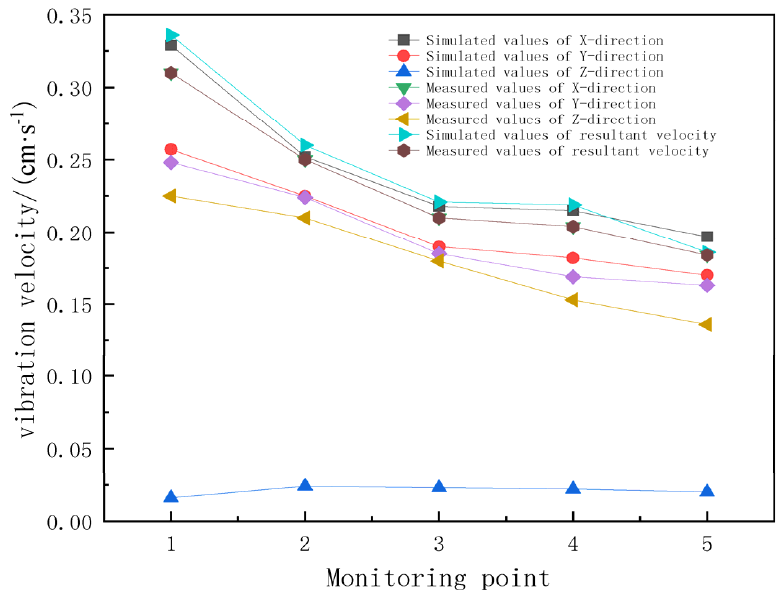
Figure 13. Comparison of numerical results with measured values for an elevation of 20 m. As can be seen from Table 6 and Figure 13, the numerical simulation results are generally greater than the field test vibration velocity data results, and their relative errors are all below 10%, and three directions peak vibration velocity decay trends do not differ much and remain basically the same. Since the numerical simulation ignores the internal structure of the actual rock mass, it simplifies the model as a continuous medium, and does not consider the influence of rock fracture zones, topography, and discontinuous surfaces, etc., thus making the numerical simulation calculation results generally greater than the results of field test monitoring. The relative error in the horizontal radial direction is basically greater than the error in the vertical direction, but the total error is not large. The peak vibration velocity in all three directions decay strictly with increasing the horizontal distance of the explosive center, and are basically consistent with field measurements. Analysis of the shear stress response of the five measurement points and the field actual measurement program to maintain consistency with the corresponding unit as shown in Figure 14, respectively, units 6339, 6179, 6019, 5859, 5699, extract the maximum shear stress in its five units with time data, as shown in Figure 15.